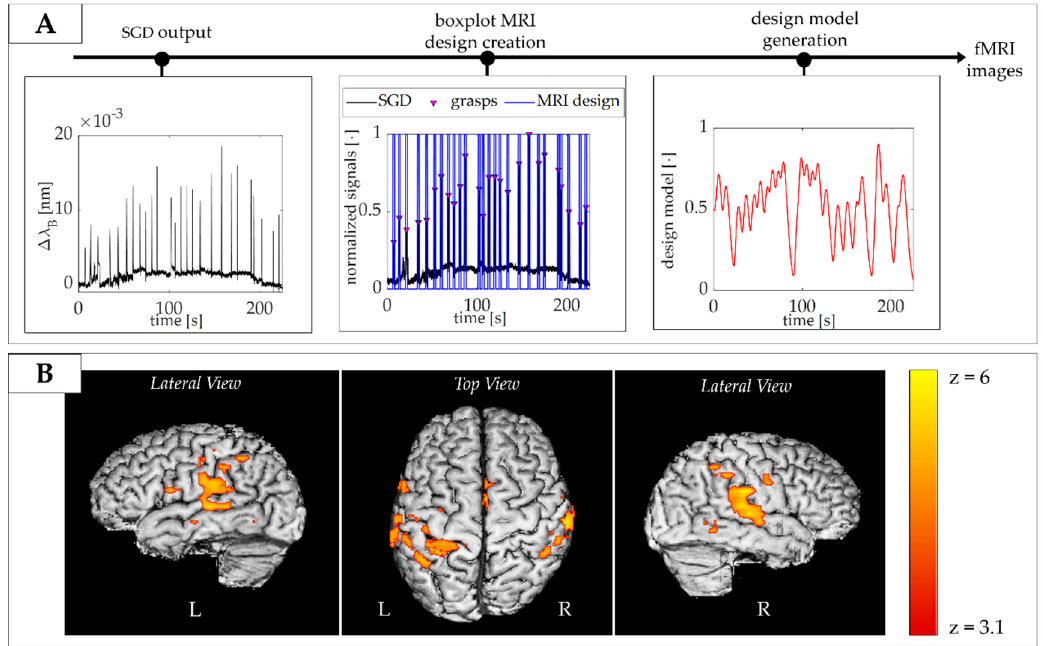
Figure 10. ( A ) Flow of data analysis. The peak in ∆ λ B coming from the SGD were used to infer the timing of the action and create a boxplot MRI design. This was convolved with the hemodynamic response function (HRF) to generate the design model for the general linear model (GLM); ( B ) Significant cluster of functional response to the task (in red and yellow) overlaid onto the subject’s T1-weighted brain image with the z-score map.